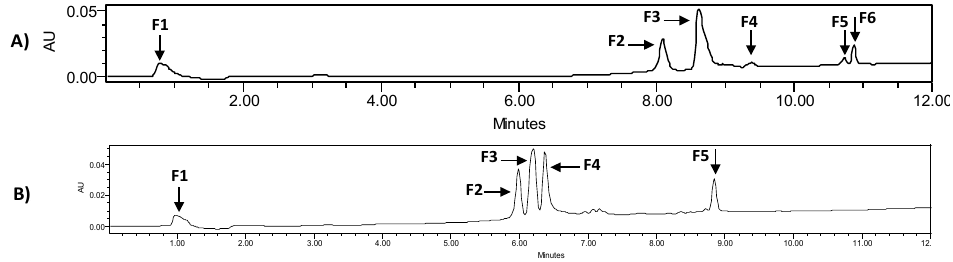
Figure 6. Chromatograms obtained for: ( A ) Solieria filiformis PPs; ( B ) Ecklonia arborea PPs, detection at 270 nm. The fractions collected are numbered (F1–F6) as indicated.